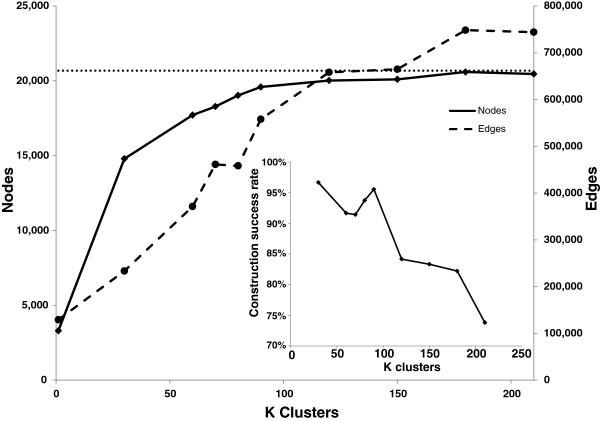
Co-expression interaction capture. Primary graph shows total unique node (solid line) and edge (dashed line) accumulation in all GIL collections at various cluster sizes, K. Dotted line at 23,244 nodes is the maximum number of genes measured by ATH1 array. Inset graph shows the success rate of possible GILs constructed from cluster size, K.